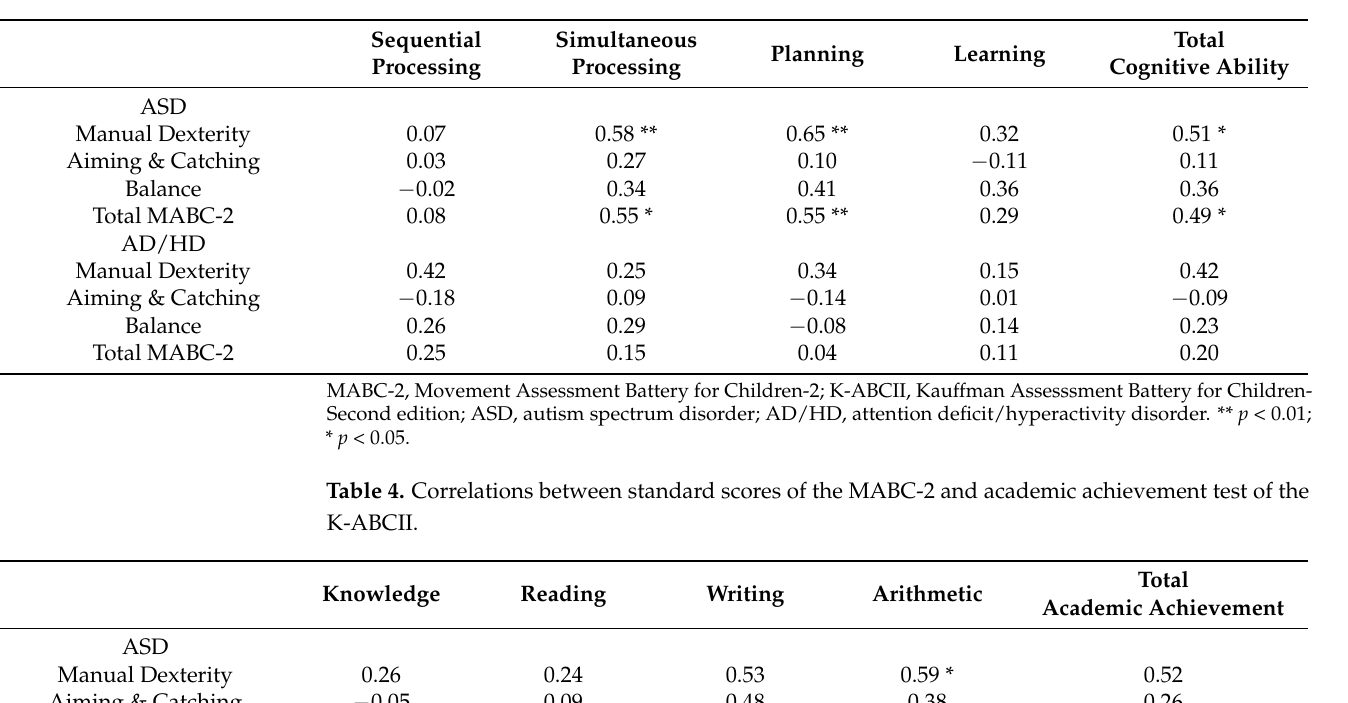
Table 3. Correlations between standard scores of the MABC-2 and cognitive ability test of the K-ABCII.